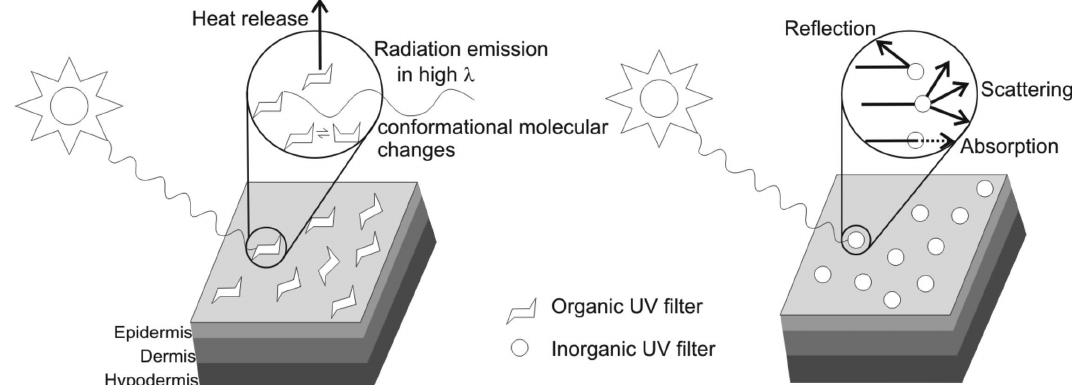
FIGURE 1 – Action mode of organic (left) and inorganic (right) UV